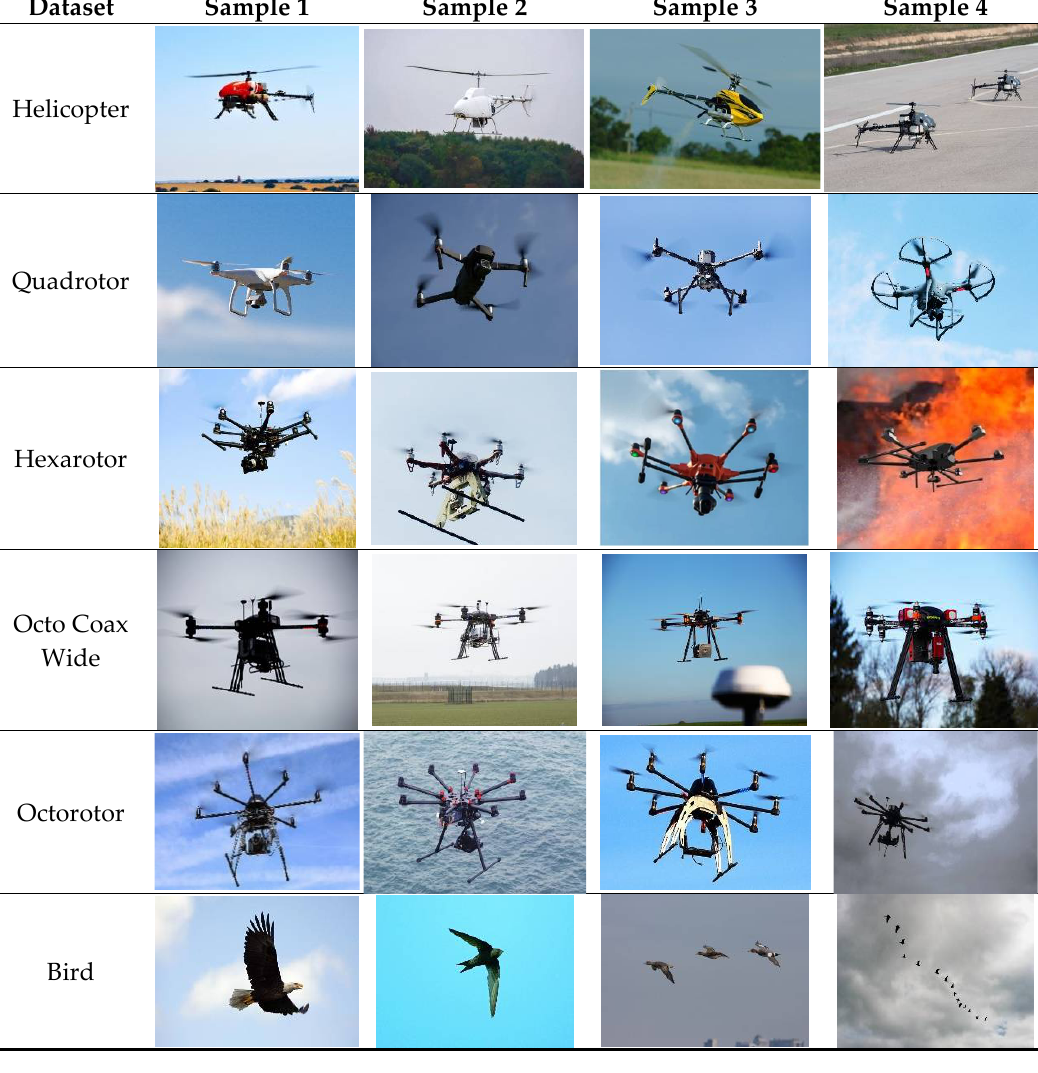
(8) To start the training step of the deep learning network, the number of batches and learning rate is set to 1 and 0.0005, respectively. The subdivision is set to 64 according to the GPU type used, and the size of each of the input images is 160 × 160.The steps are changed to 16,000, 18,000 using the formula (80% maximum batches, 90% maximum batches). Finally, the model is trained with 20,000 iterations, and the weights file is saved after every 10,000 iterations. The overall view process of training the network and reduc- ing the average loss until 0.52 after 20,000 iterations and 23 h is presented in Figure 13. To